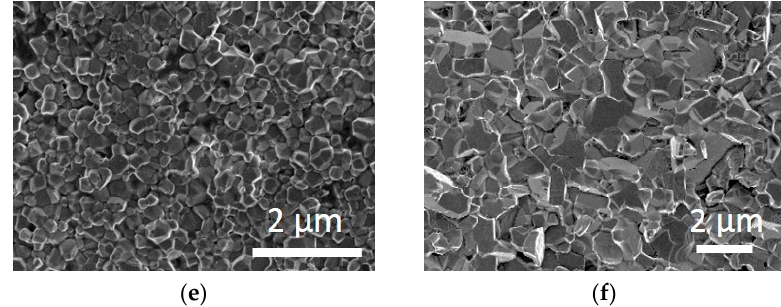
Figure 7. SEM micrographs of fractured ZnO samples after sintering ( a ) SFTR nanopowder sintered naturally at 900 ◦ C for 2 h, ( b ) Nabond nanopowder sintered naturally at 900 ◦ C for 2 h, ( c )